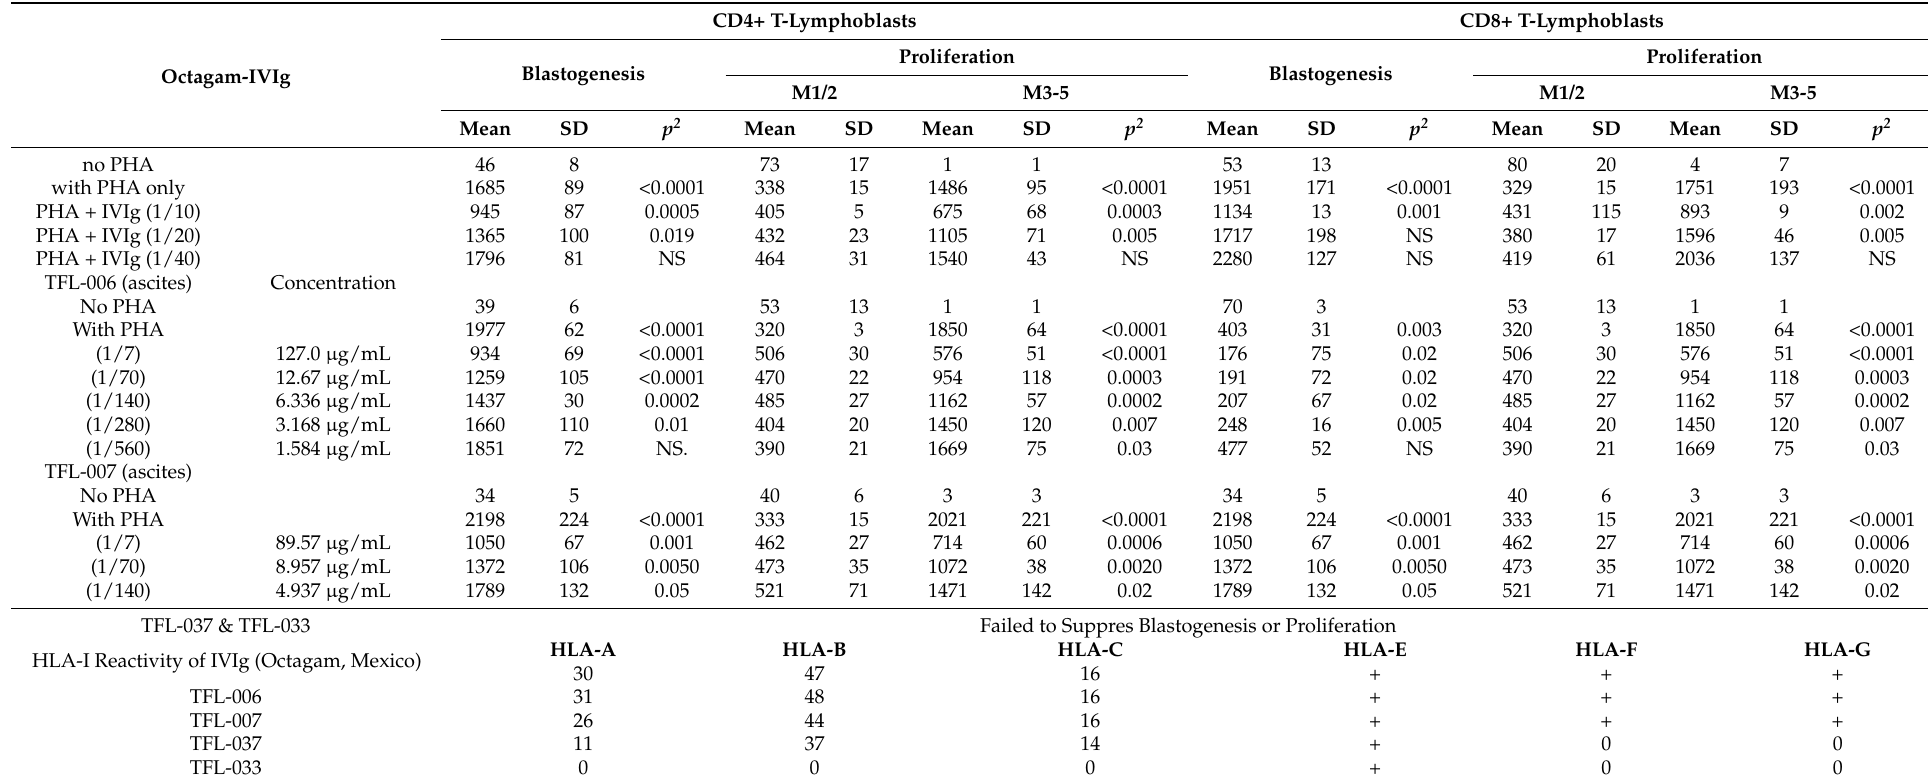
Table 8. Dose-dependent inhibition of blastogenesis and proliferation of activated